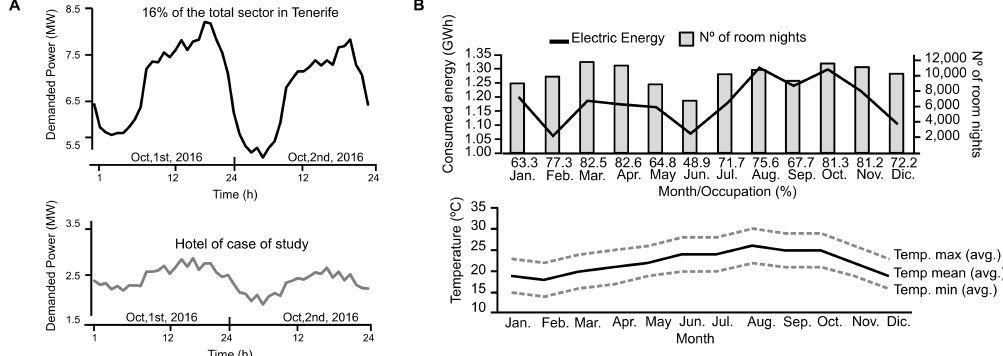
Figure 1. Energy and occupancy in 2017 in the hotel under study. ( A ) Power demand profile in hospitality sector. Elaborated with information provided by ENDESA and a luxury 5-star hotel. ( B ) Energy consumed and occupancy in 2017 in the hotel, and exterior temperature variation along 2017 from the nearest meteorological station, i.e., at the Tenerife South Airport (GCTS) (Source